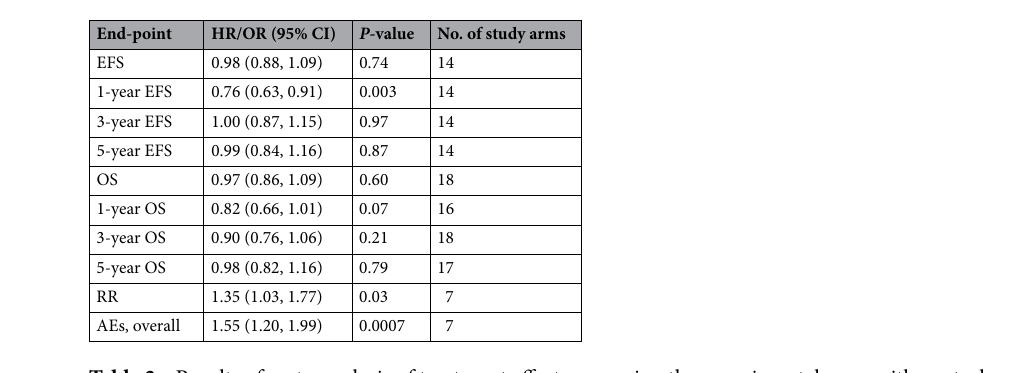
Table 2. Results of meta-analysis of treatment effect comparing the experimental arms with control arms. Abbreviations: AE, adverse event; CI, confidence interval; EFS, event-free survival; HR, hazard ratio; OR, odds ratio; OS, overall survival; RR, response